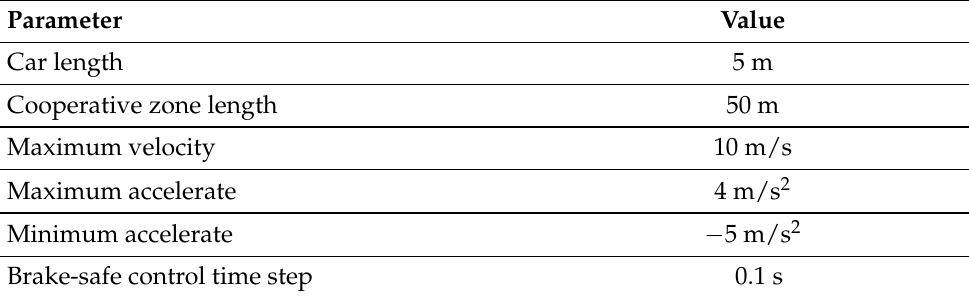
Figure 7. Intersection model used in our experiments. Table 1. System